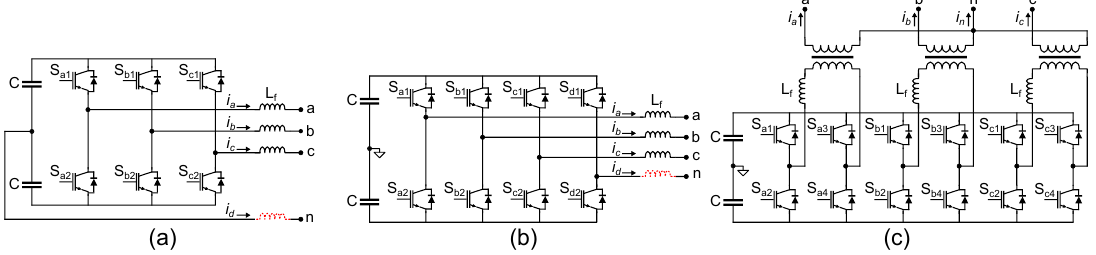
Figure 8. Main topologies of two-level four-wire APFs: ( a ) three-leg voltage source converter (3L-VSC); ( b ) four-leg voltage source converter (4L-VSC); ( c ) six-leg converter (6L). The optional fourth inductance is drawn with dashed red lines.